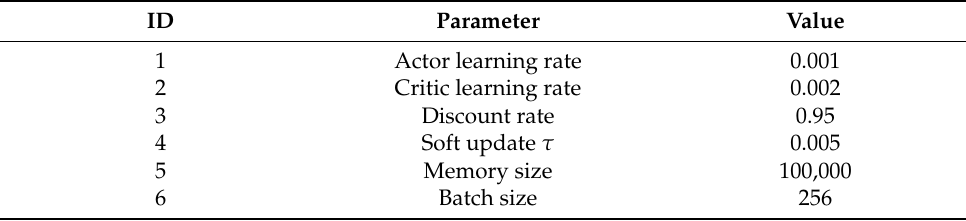
Table 1. List of Parameters Used in DDPG